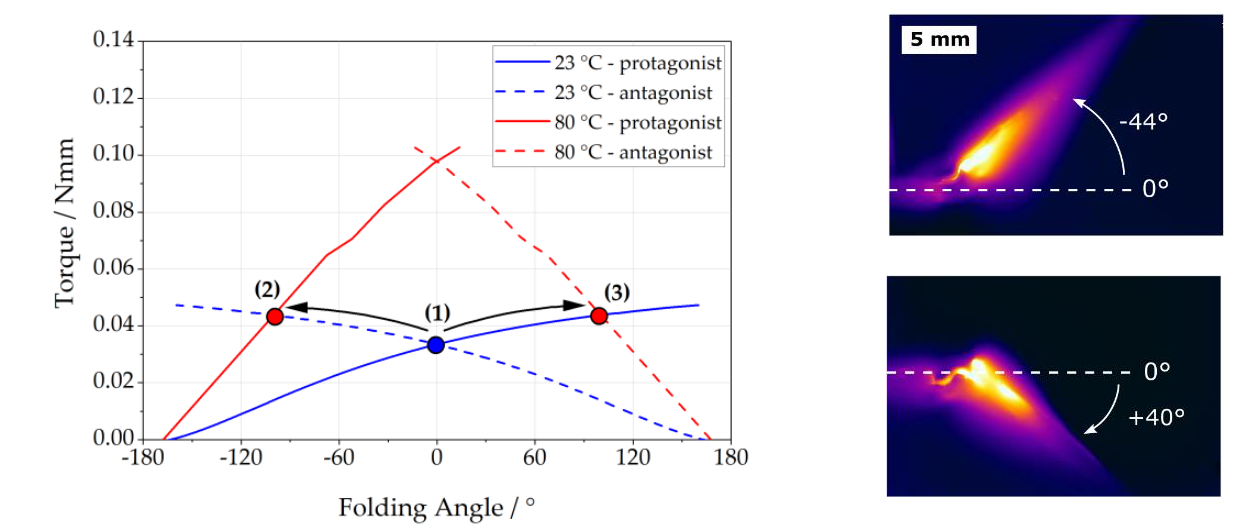
Figure 11. Torque versus folding angle characteristics of the protagonist and antagonist of an antagonistic microactuator for the case of pre-deflection by 360°. By heating either the protagonist or antagonist, the equilibrium point moves from (1) to either (2) or (3).